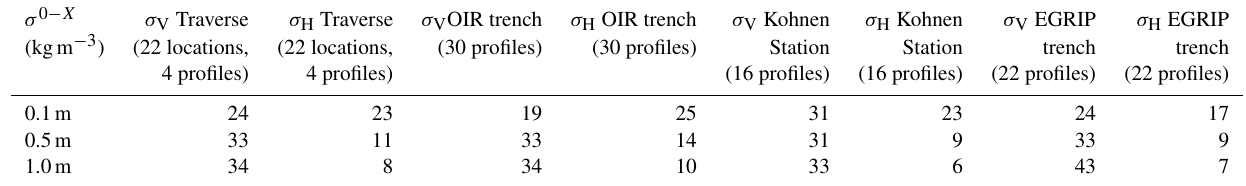
Table 4. Comparison of σ (horizontal and vertical) for each depth interval (from surface to respective depth) of samples from the traverse and OIR trench (this study), Kohnen Station and a trench from EGRIP (Schaller, 2018). σ 0 − X σ V Traverse